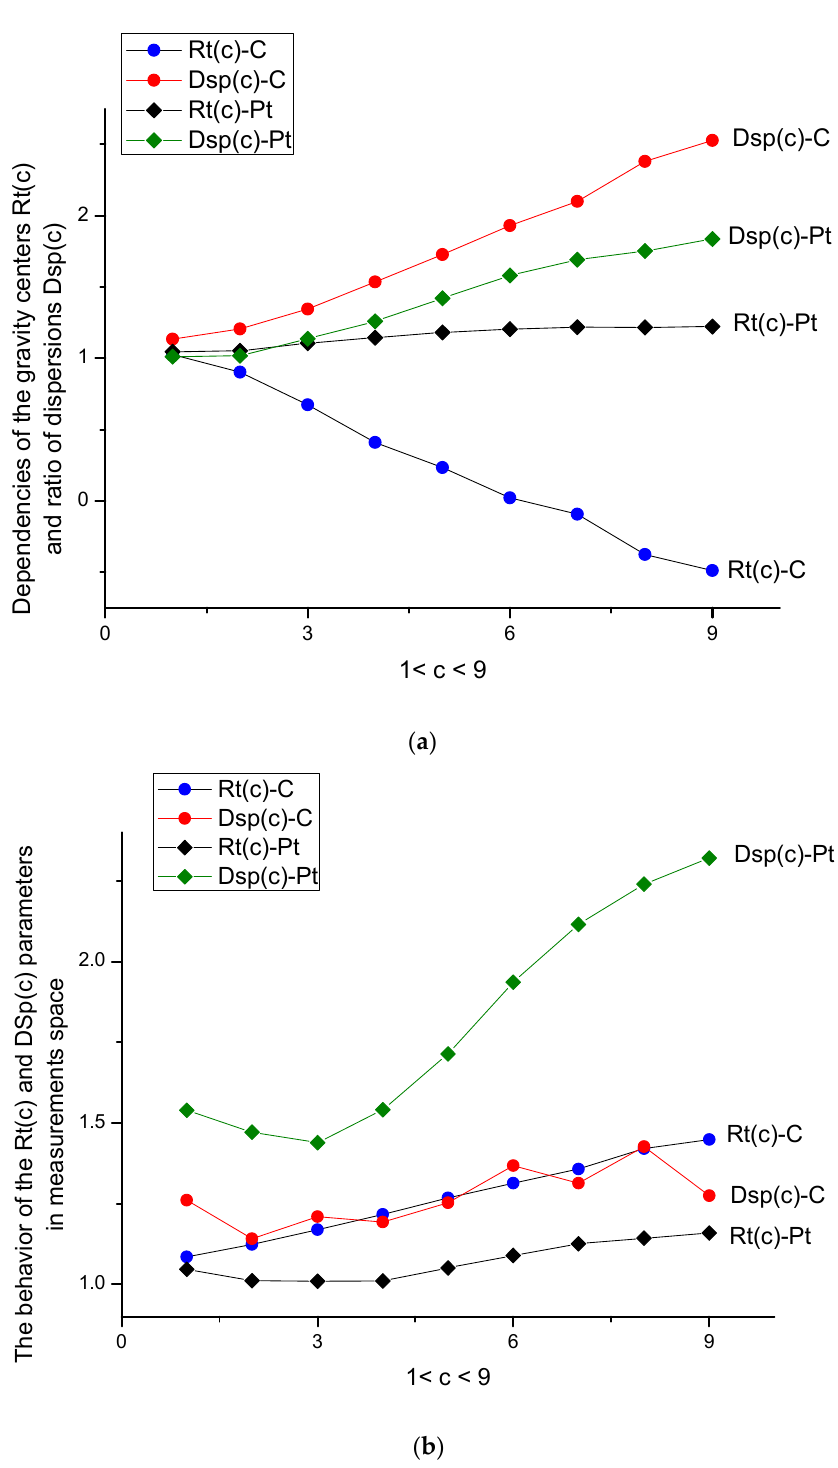
Figure 4. ( a ) Behavior of parameters Rt( c ) = <y>/<x> and Dsp( c ) = <D Y 2 >/<D X 2 > for two types of electrodes in data space. All these curves changed monotonically with respect to the increase in D -tryptophan concentration. The true c-values are given in Table 2. ( b ) Behavior of the same parameters Rt( c ) = <y>/<x> and Dsp( c ) = <D Y 2 >/<D X 2 > is shown for two types of electrodes in the measurement space. Only two curves of Rt( c ) for two types of electrodes kept their monotone behavior, while the two other curves for dispersion ratios lost (completely or partly) their monotone behavior.